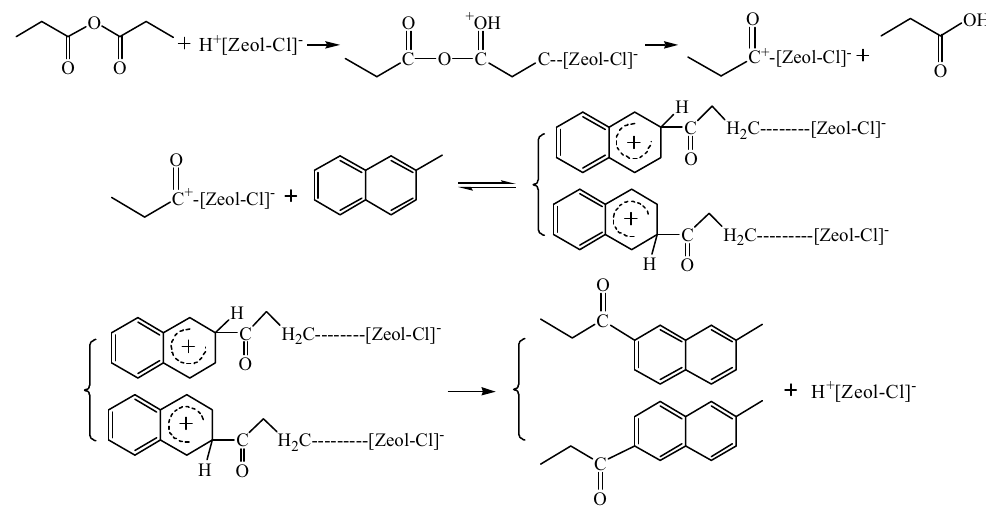
Figure 13: Mechanism of 2 - MN propionyl catalyzed by zeolite molecular